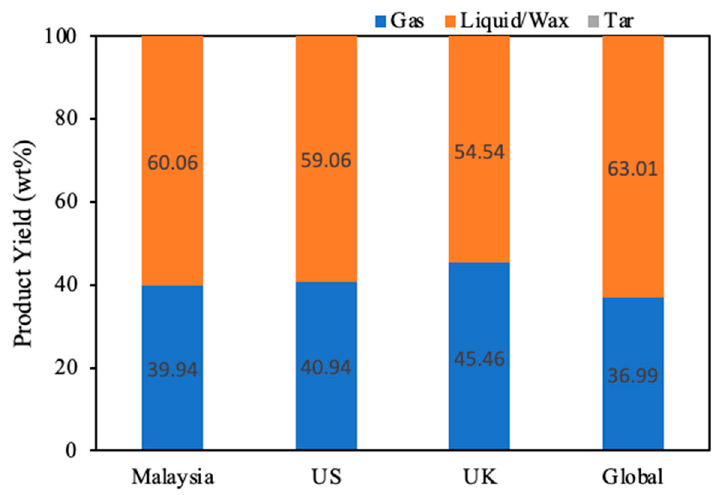
Figure 5. Product distribution for 1 g bentonite pyrolysis of mixed plastic waste at 500 °C.